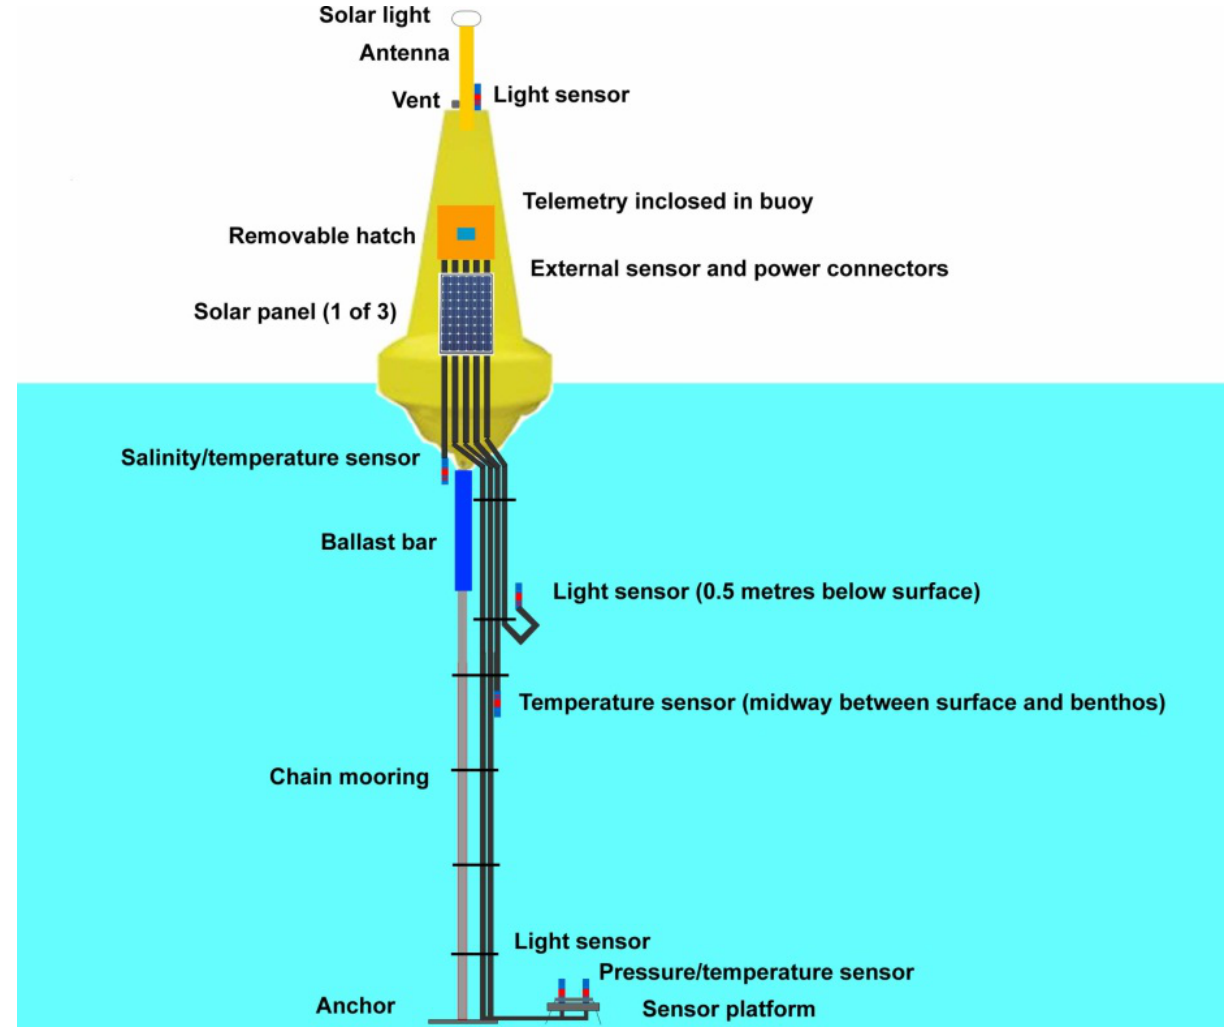
Figure 19. The conceptual setup for the Heron Island